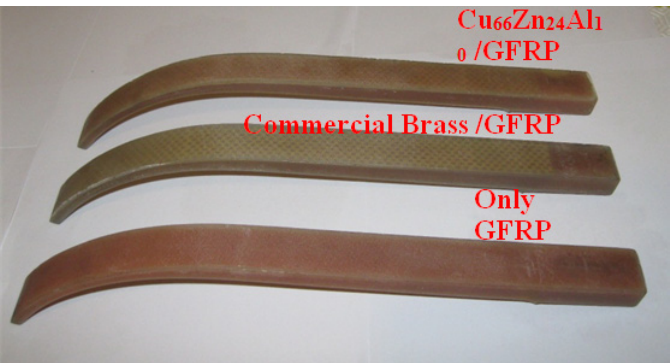
Figure 12: Final appearance of the three horn